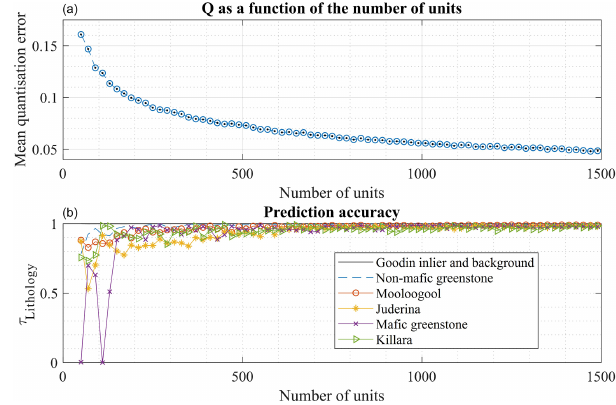
Figure 8. (a) Elbow curve of the quantization error for the deter- mination of the optimum number of neurons (or units) in SOM and (b) prediction accuracy for the different lithologies present in the training and validation datasets. Note that after 750 units, the quan- tization error for the different lithologies stabilizes and oscillates around its maximum